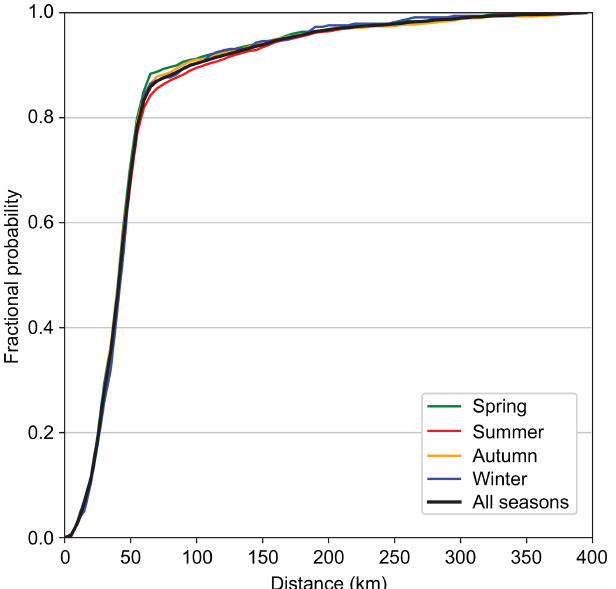
Figure 8. The cumulative distribution of the number of extreme precipitation events caused by fronts from Kunkel et al. (2012) as a function of the distance to the nearest front identified by DL- FRONT in MERRA-2 for 1980–2013.